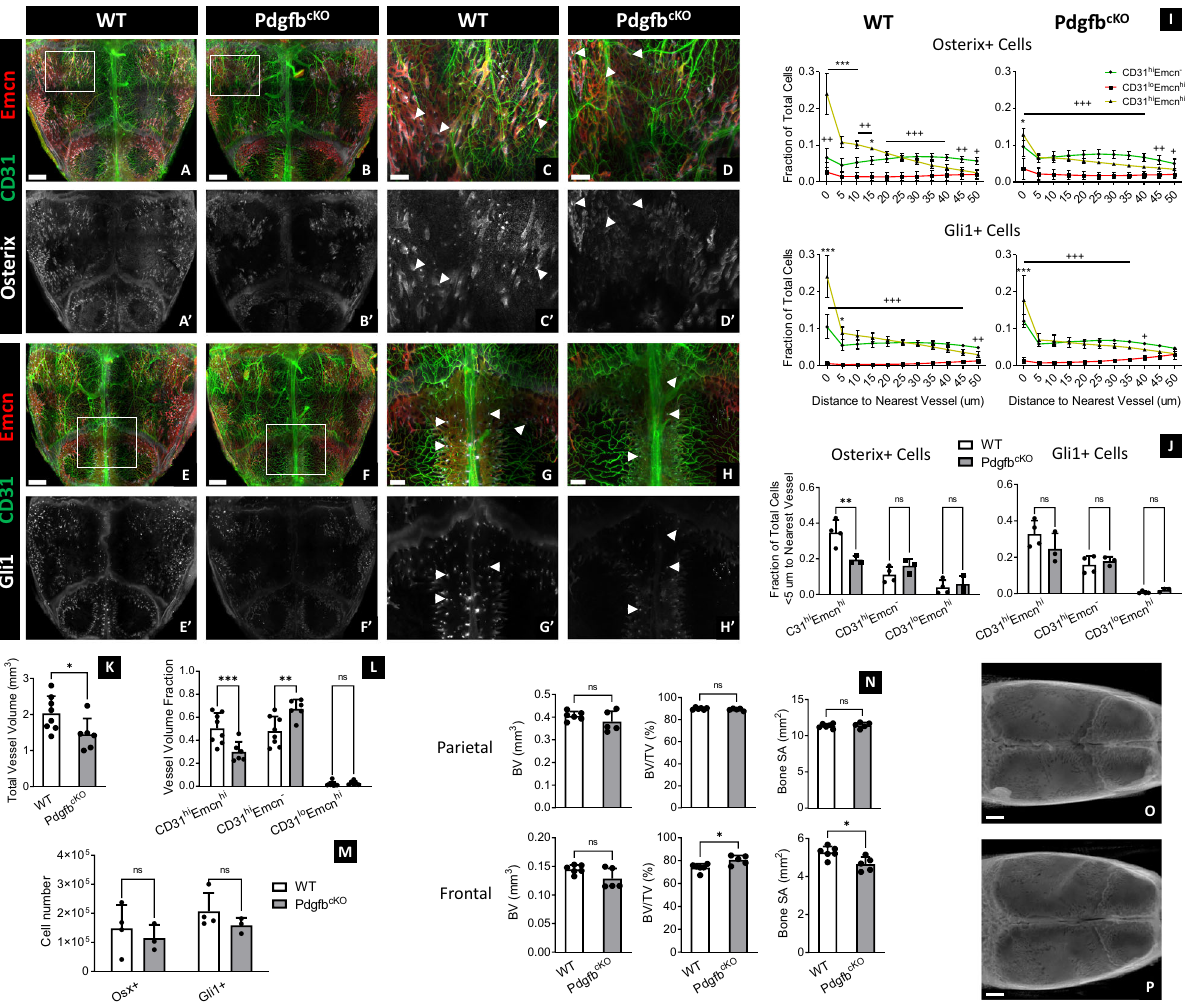
Fig. 5 Knocking out PDGF-BB expression in TRAP + osteoclasts decreases CD31 hi Emcn hi vasculature and their association with Osterix + and Gli1 + skeletal progenitors. A – H MIP of vessels ( A – H ), Osterix + progenitors ( A – D , A' – D' ), and Gli1 + progenitors ( E – H , E' – H' ) from the calvaria of 4-weeks-old WT and Pdgfb cKO mice. Protein expression of CD31 and Emcn in vessels and Osterix or Gli1 in skeletal progenitors is markedly reduced in Pdgfb cKO calvaria at the transcortical canals (arrowheads) and osteogenic fronts nearby the sutures. Results were replicated in 4 WT calvaria and 3 Pdgfb cKO calvaria for each staining combination (14 total calvaria). I Spatial distribution of Osterix + and Gli1 + cells relative to each vessel phenotype in WT and Pdgfb cKO calvaria (WT: n = 4 Osterix, n = 4 Gli1; Pdgfb cKO : n = 3 Osterix, n = 3 Gli1). J Fraction of Osterix + and Gli1 + progenitors within 5 μ m of their nearest vessel in WT and Pdgfb cKO calvaria (WT: n = 4 Osterix, n = 4 Gli1; Pdgfb cKO : n = 3 Osterix, n = 3 Gli1). Signi fi cantly fewer Osterix + cells are associated with CD31 hi Emcn hi vessels in Pdgfb cKO calvaria compared to the WT control. K – M Total vessel volume ( K ), fractional vessel phenotype volume ( L ), and skeletal progenitor number ( M ) in the calvaria of WT versus Pdgfb cKO mice ( n = 8 for WT and n = 6 for Pdgfb cKO in K – L ; M : n is the same as in I and J ). N MicroCT quanti fi cation of bone volume (BV), bone volume to tissue volume (BV/TV) percentage, and bone surface area (SA) in the parietal and posterior frontal bones of WT and Pdgfb cKO calvaria (WT: n = 6; Pdgfb cKO : n = 5). O , P MicroCT 3D volume projections of WT ( O ) and Pdgfb cKO calvaria ( P ). Data are mean ± SD. Statistics were performed using a two-way ANOVA with Bonferroni post-hoc test ( I , J , L , M ) or two-tailed t -test ( K , N ). *** p < 0.001, ** p < 0.01, * p < 0.05 where designated or between CD31 hi Emcn hi and CD31 hi Emcn − vessels in l ; +++ p < 0.001 between CD31 lo Emcn hi and CD31 hi Emcn − vessels ( I ). Exact p -values for two-tailed t -tests: K p = 0.0112, N p = 0.2565 (top left), 0.0736 (bottom left), 0.2183 (top middle), 0.0152 (bottom middle), 0.6635 (top right), 0.0151 (bottom right). Scale bars: 1000 μ m ( A , B , E , F , O , P ); 300 μ m ( C , D , G , H ). Colors: Red: Endomucin (Emcn), Gray: Osterix ( A – D ) or Gli1 ( E – H ), Green: